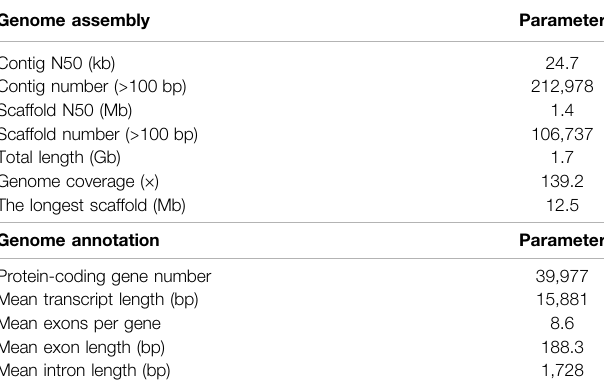
TABLE 1 | Statistics of the genome assembly for S. maitianheensis